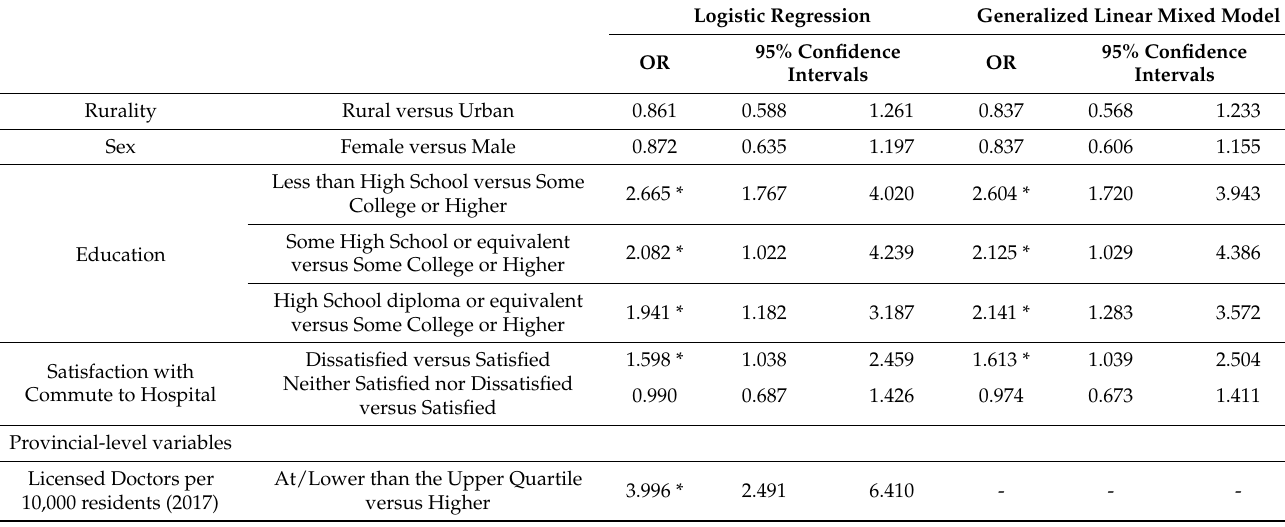
Table 3. Adjusted analysis for the likelihood of forgone